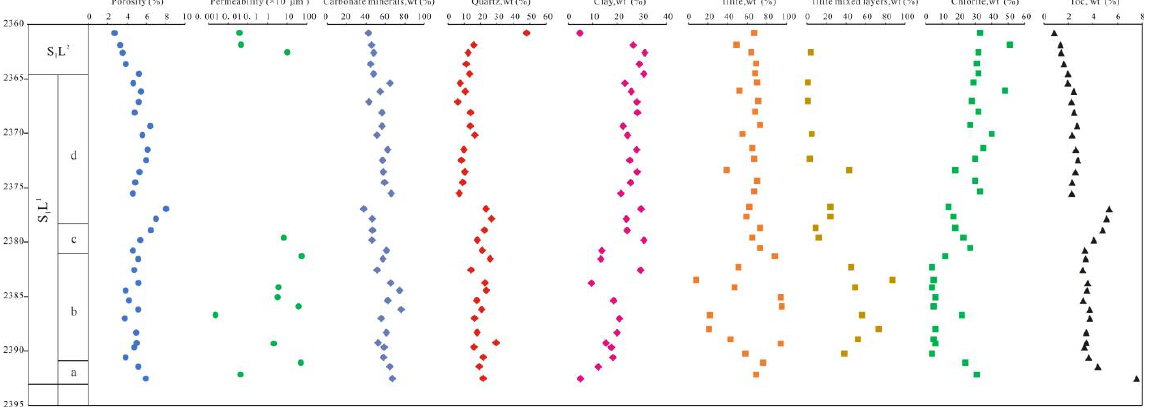
Table 2. Contents of minerals of S 1 l 1 member shale from the QEMSCAN result.